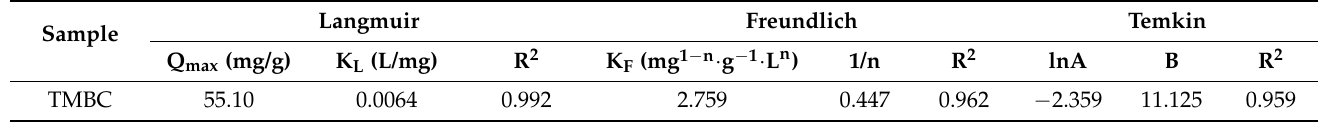
Table 2. Model fitting parameters for isothermal adsorption of Cr (VI) by